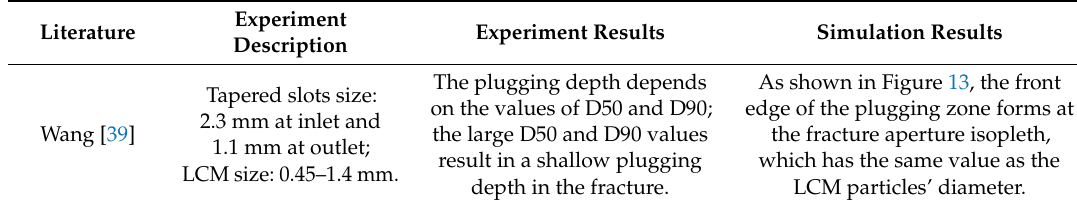
Table 2. Simulation results of this study and those of other